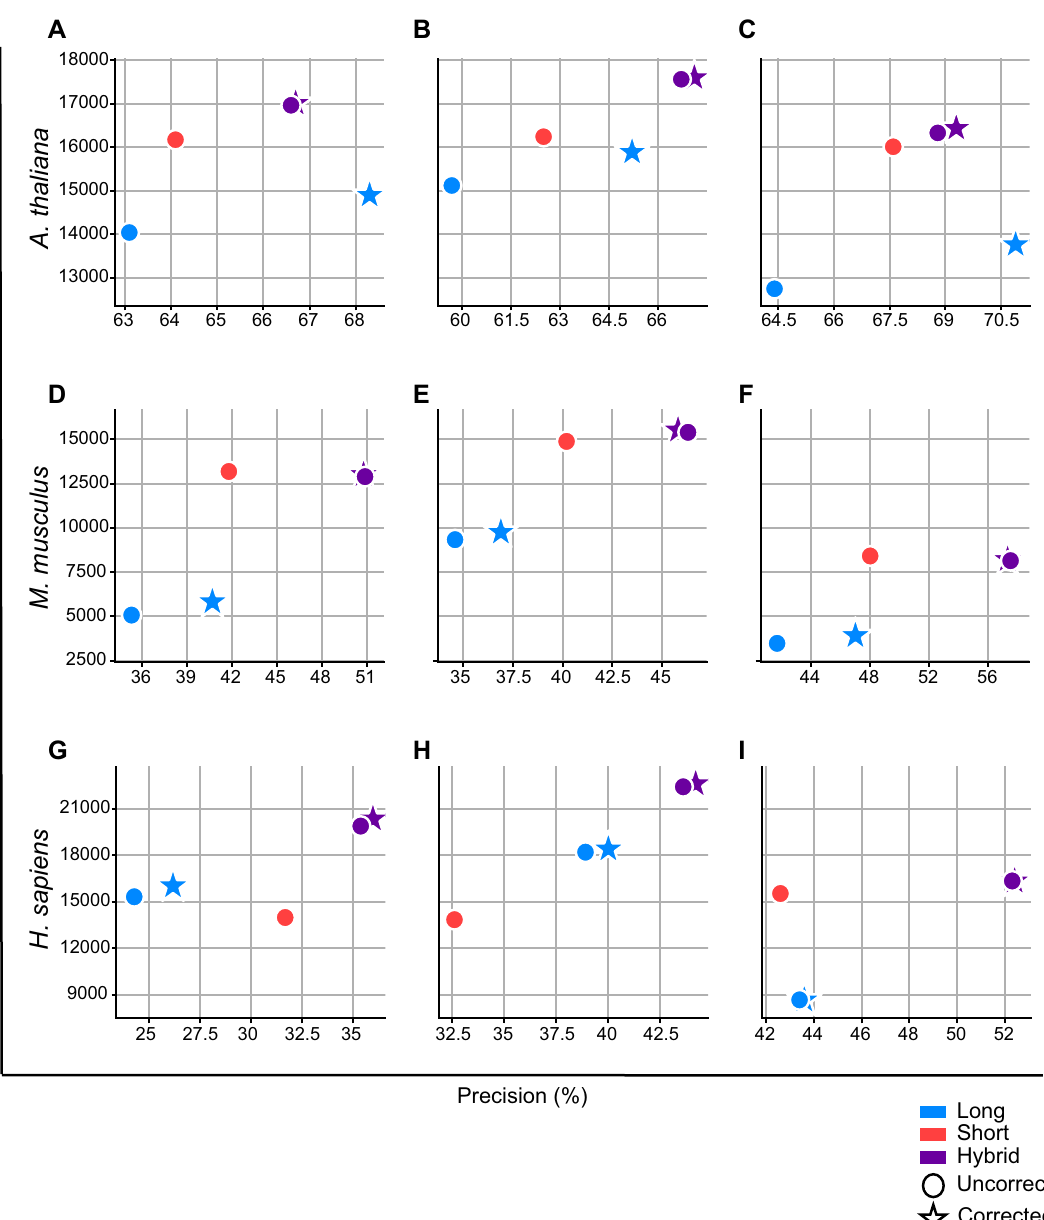
Fig 3. Precision and the number of annotated transcripts assembled for 9 real datasets from Arabidopsis thaliana , Mus musculus , and human. Only loci with long read expression are considered for these calculations The circle markers represent assemblies created from uncorrected reads, and the stars represent assemblies created from long-reads corrected with TALC. The long and short read combinations analyzed from Arabidopsis thaliana were A) ERR3486096 and ERR3764345 B) ERR3486098 and ERR3764349 C) ERR3486099 and ERR3764351. The long and short read combinations analyzed from Mus musculus were D) ERR2680378 and ERR2680375 E) ERR2680378 and ERR2680377 F) ERR2680380 and ERR2680379. The long and short read combinations analyzed from human were G) SRR4235527 and NA12878-cDNA H) SRR4235527 and SRR4235527 I) SRR1153470 and